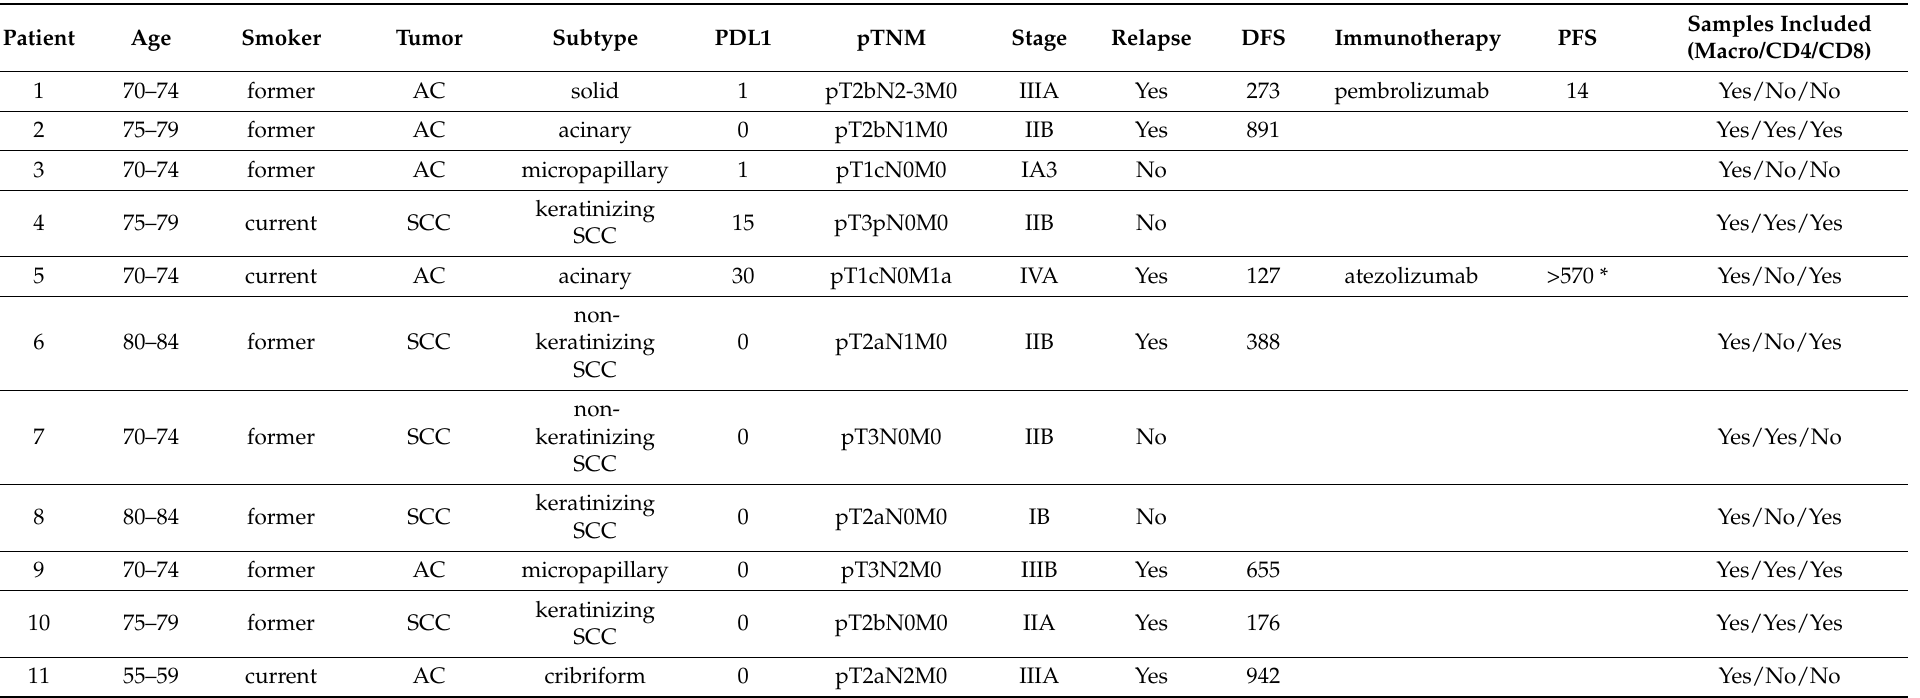
Table 1. Basic characteristics of the study